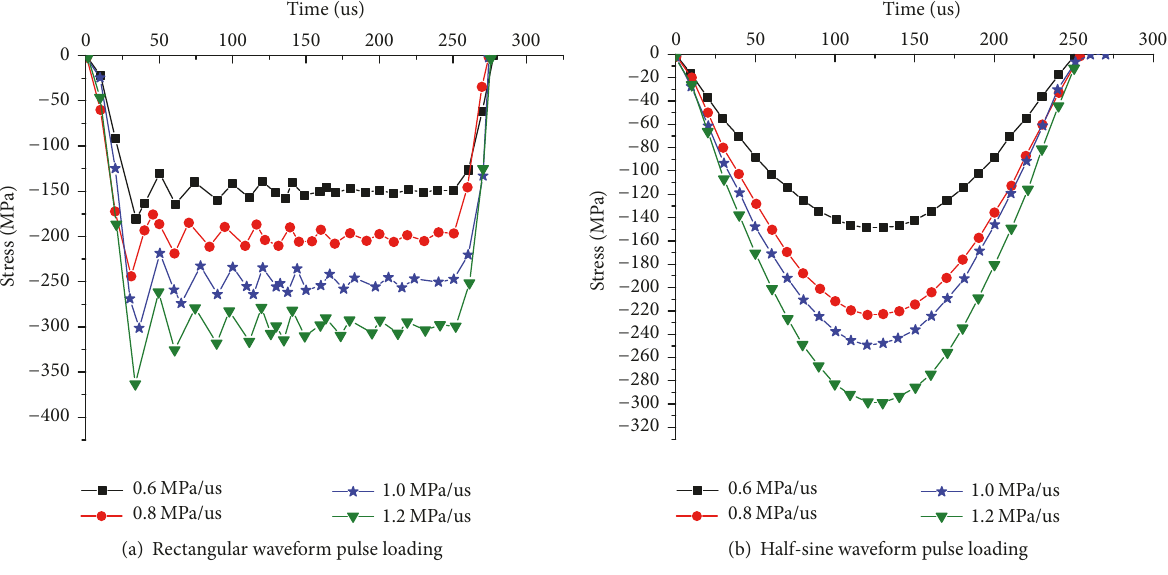
Figure 8: Time-history of stress pulses at different loading rates.